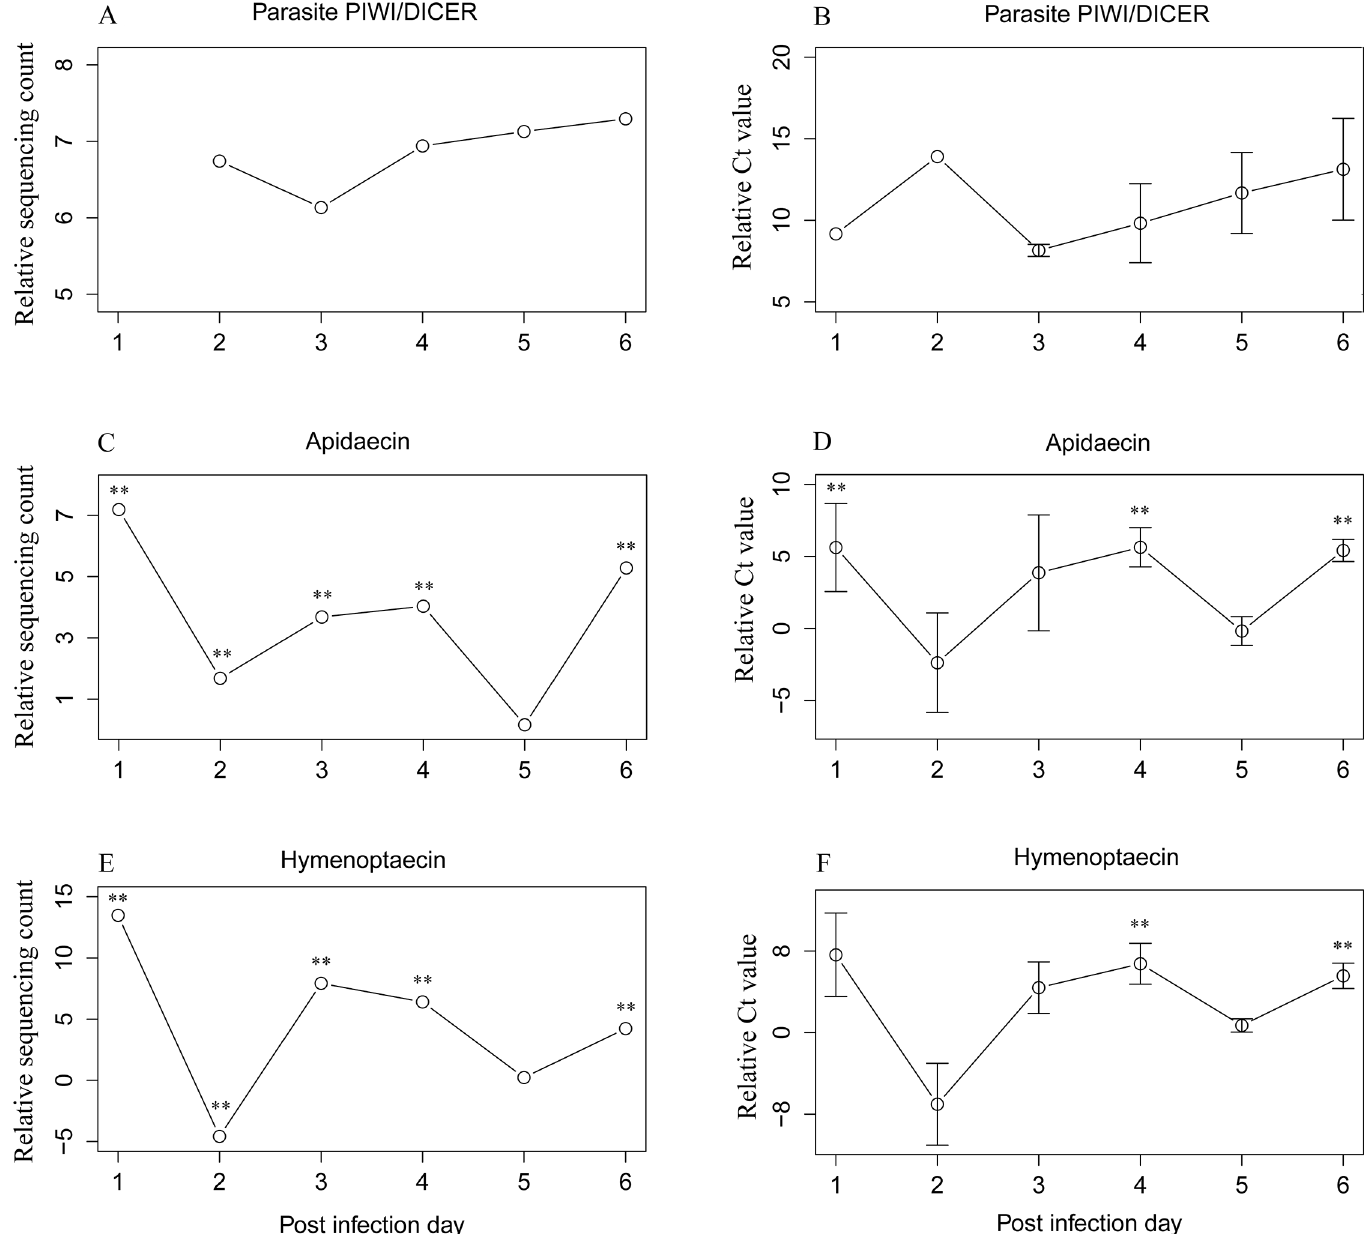
Fig 5. (A) Count ratios derived from mRNA sequencing for parasitic PIWI and Dicer. Y = Log((C PIWI /C DICER ), 2), where C PIWI represents normalized counts of parasitic gene PIWI and C DICER represents normalized counts of parasitic gene DICER. The expression of Dicer was only detected starting at 2 dpi, hence data for 1 dpi is missing. (B) Real time quantitative PCR originated expression value of the ratio between parasitic PIWI and Dicer. Y = Log((Ct DICER / Ct PIWI ), 2), where Ct DICER represents the Ct value of gene DICER and Ct PIWI represents the Ct value of gene PIWI. The expression level of PIWI is consistently higher than Dicer with the same expression pattern as sequencing data, which confirmed the validity of the sequencing data. (C) mRNA sequencing originated counts of immune gene Apidaecin , which shows significant change over the infection time with a similar expression pattern of qPCR results showed in (D). (E) The mRNA sequencing data of Hymenoptaecin again showed significant change over the infection time and shared the same expression pattern as the qPCR results in (F). The consistent expression pattern between the sequencing data and the qPCR results validated the accuracy of the sequencing data. Error bar represents standard error. * represents the significant level at 0.05. ** represents the significant level at